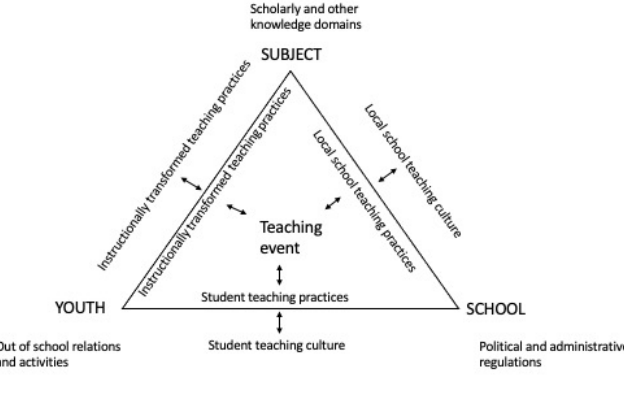
Figure 1: Model of analysis of the didactic event in teaching (after Christensen,